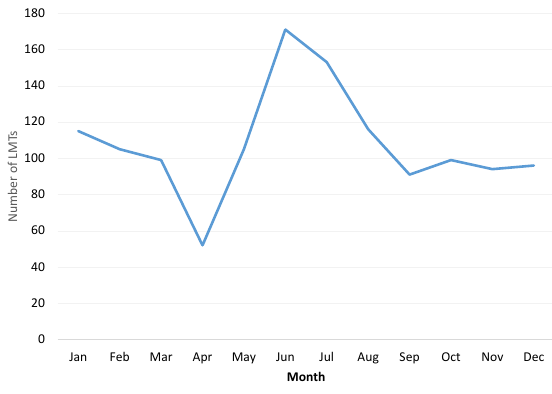
Figure 3 . Seasonality of Last-Minute Traveler Clinic Attendance.